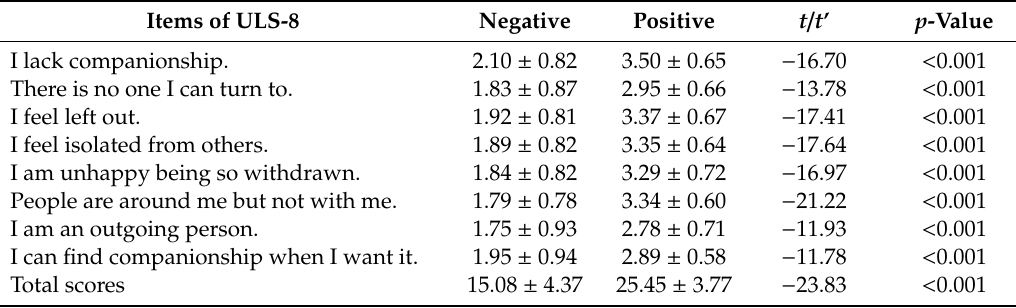
Table 3. Assessment results of each item of ULS-8 ( x ±